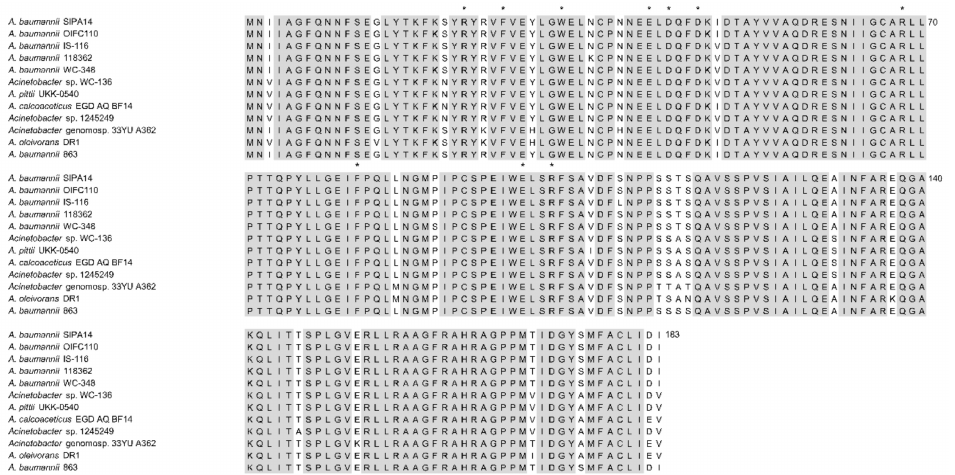
Figure 2. Multiple sequence alignment of autoinducer synthase protein sequence of strain 863 and other Acinetobacter species. Identical residues are highlighted in grey. All 10 invariant residues in autoinducer synthase homologues are labelled with asterisks. National Center for Biotechnology Information (NCBI) accession numbers: A. baumannii SIPA14 (OXU71347), A. baumannii OIFC110